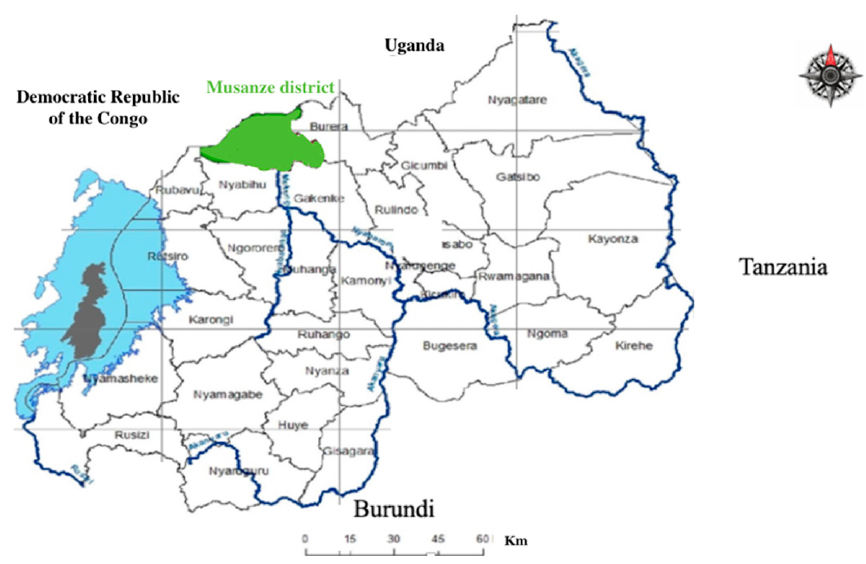
Figure 1. Rwanda and Musanze district location.